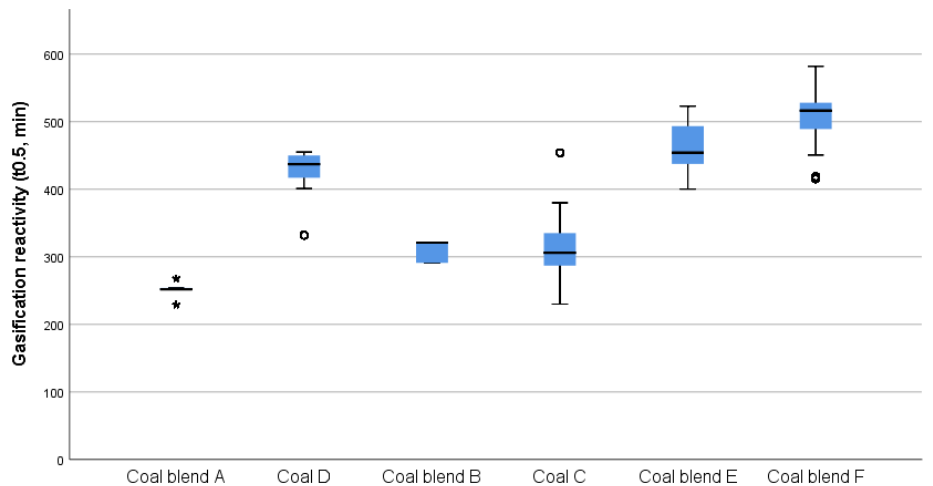
Figure 13. Box plots of the range of coke addition rates for the time periods corresponding to the addition of different coals/coal blends during blast furnace production (◦ = high/low potential out- liers and * = high/low extreme values).